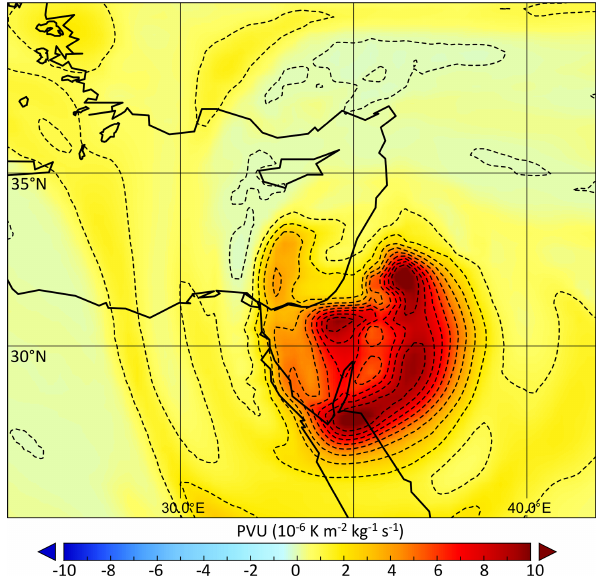
Figure 4. Potential vorticity units (PVU) at 300hPa for 26 April 00:00UTC, taken from ERA-5 at 30km spatial resolution. The major feature is a closed positive anomaly (with maximum of Km − 2 kg − 1 s − 1 ), corresponding to a cut-off low centred over north-western Saudi Arabia.